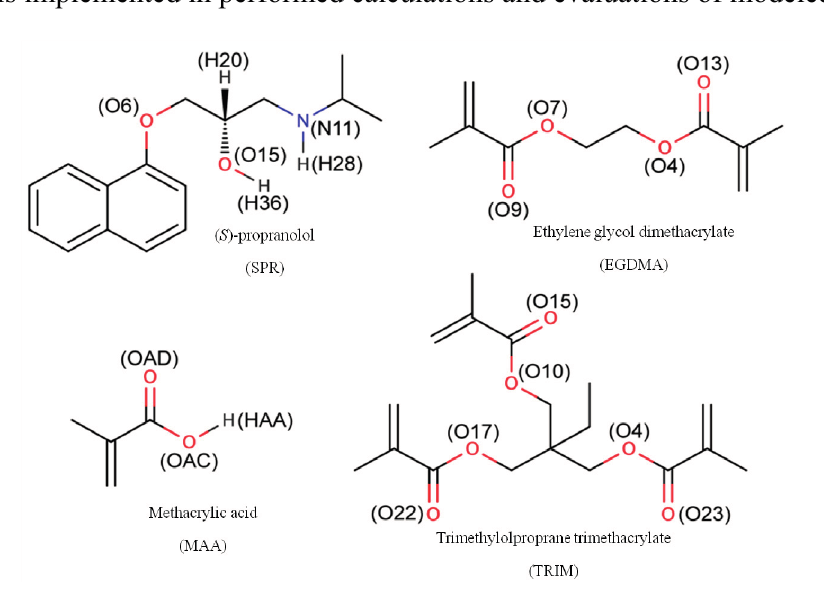
Figure 3. Structures of compounds used in this study with molecular abbreviations